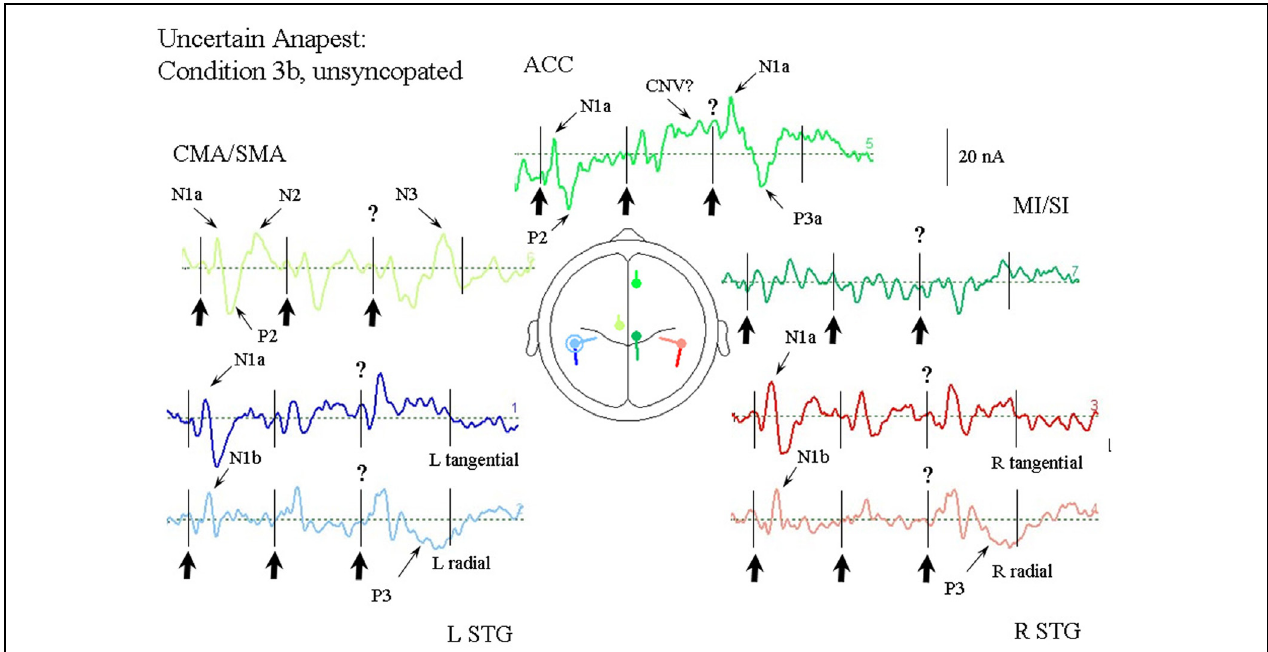
FIGURE 7 | Response of the optimum source model to the unsyncopated but uncertain anapest case, i.e., with third click present (condition 3a). Beat onsets are indicated by vertical bars and click stimulus onsets by bold arrows. The uncertainty over the present third click is indicated by a question mark. The presence of uncertainty in this case produces generally